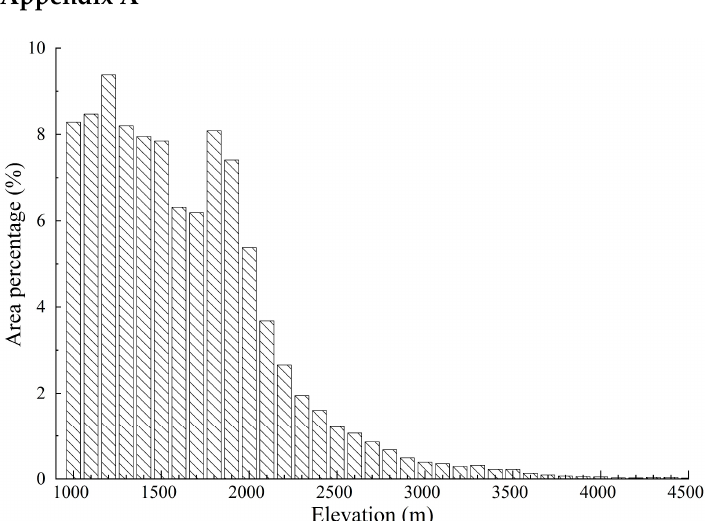
Figure A1. Cropland area percentage at each elevation bin from 1000 m ASL to 4500 m ASL.